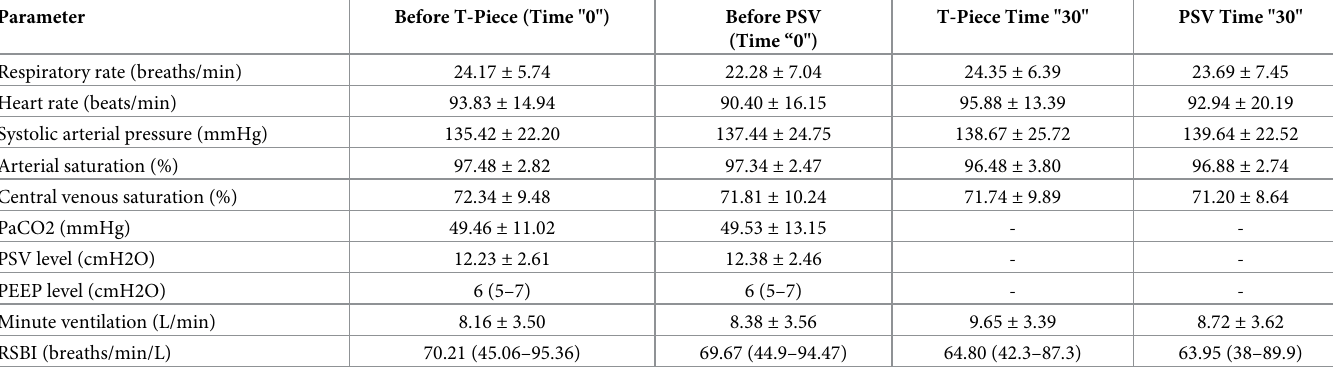
Table 2. Physiological Parameters at 0 and 30-minutes